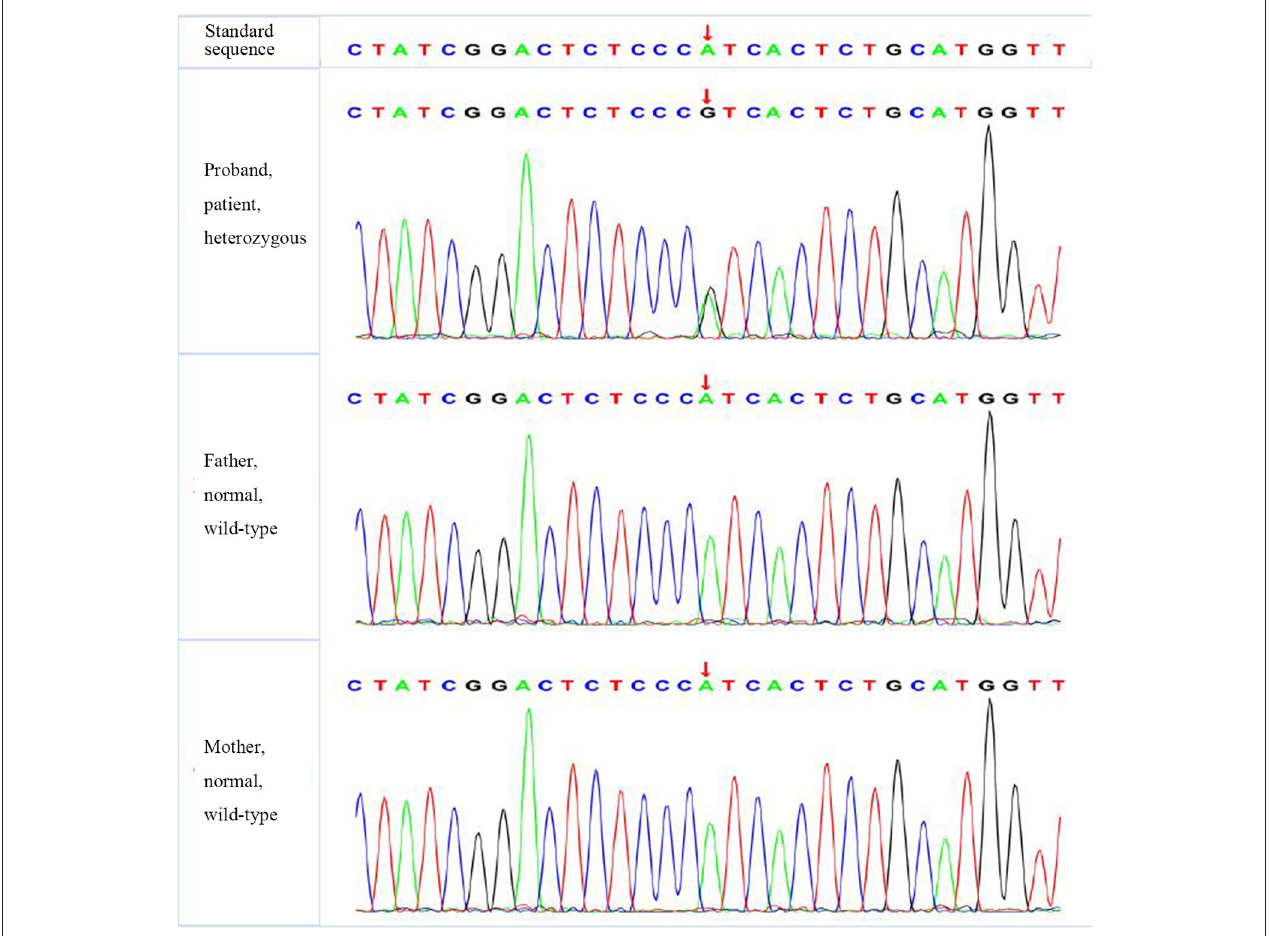
FIGURE 2 | The verification results of FGFR1 . FGFR1 :c.1028 (exon 9) A >